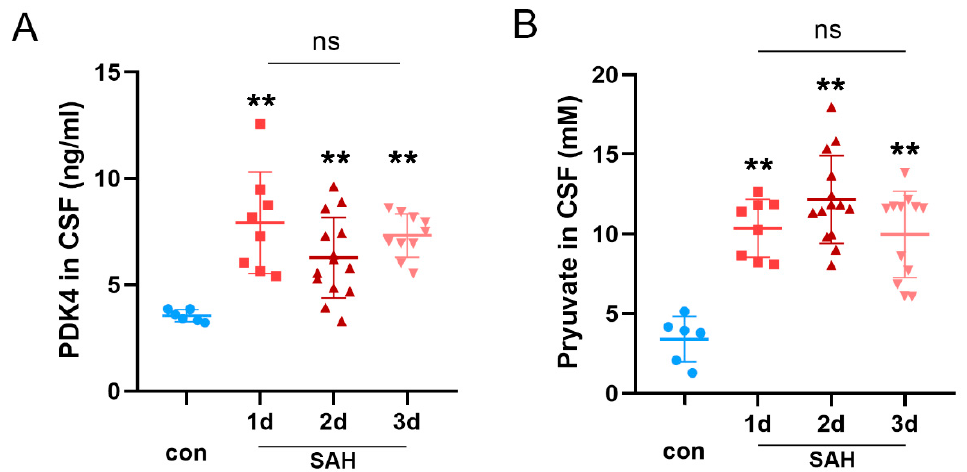
Figure 6. Scatter plots of the levels of PDK4 and pyruvate in controls and patients with SAH. Quantitative analysis of ELISA results showed that the levels of PDK4 ( A ) and pyruvate ( B ) were obviously increased in the CSF of patients 1–3 days after SAH compared with controls. Bars represent the means ± SD. ** p < 0.01 vs. con ( n = 6 in the con group; n = 8, 14 and 10 in the groups on days 1, 2 and 3 after SAH, respectively).